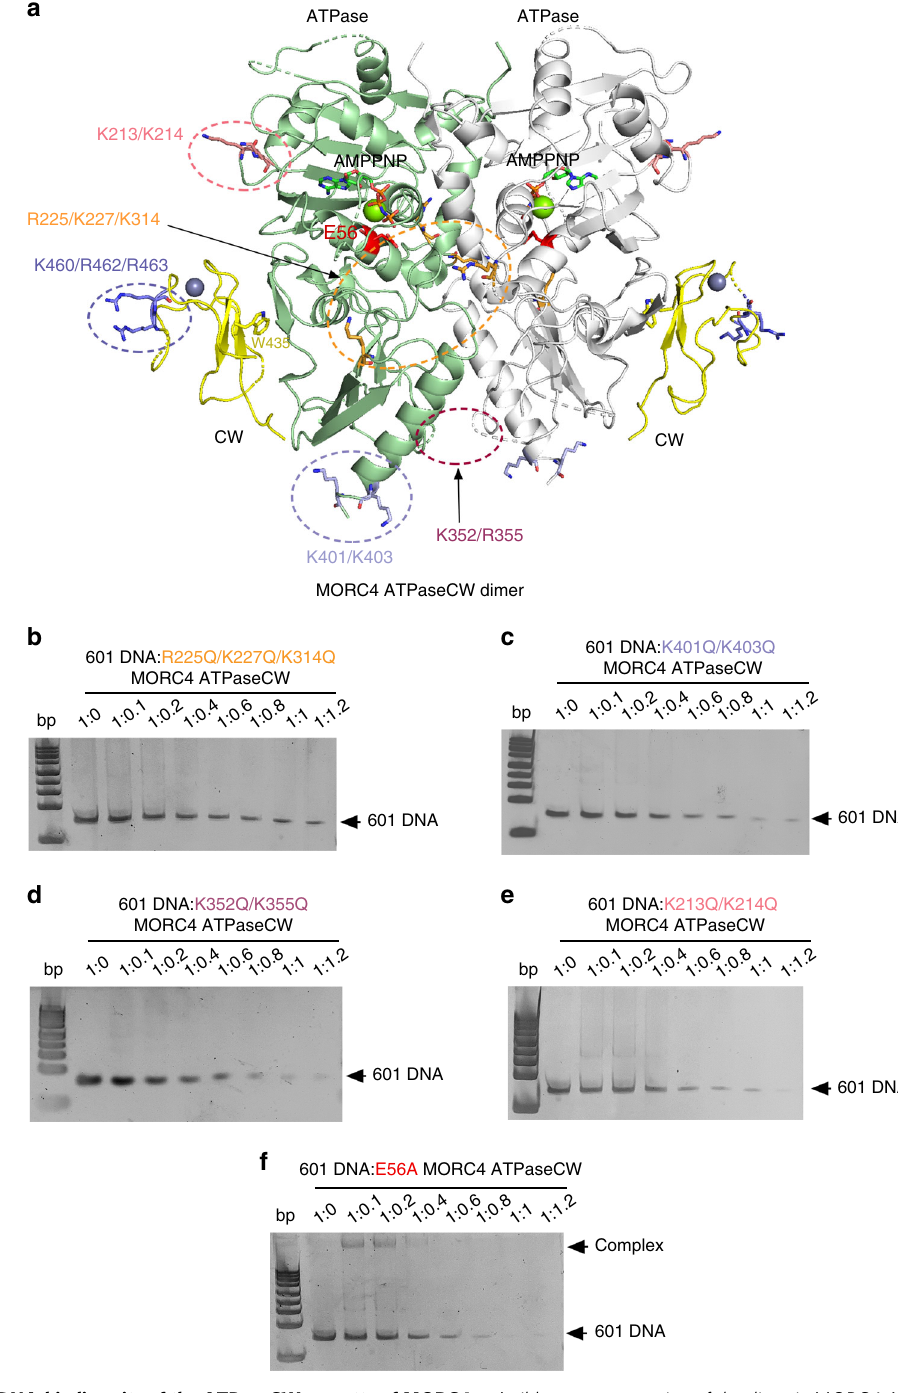
Fig. 5 Mapping the DNA-binding site of the ATPaseCW cassette of MORC4. a A ribbon representation of the dimeric MORC4 ATPaseCW structure. The CW domain is colored yellow, and the ATPase domain is colored green in protomer A and gray in protomer B. The positively charged clusters in ATPaseCW are indicated by ovals and labeled. The residue E56, required for the catalytic activity of ATPaseCW, is also shown in red. b – f EMSA with 601 DNA in the presence of increasing amounts of indicated mutants of MORC4